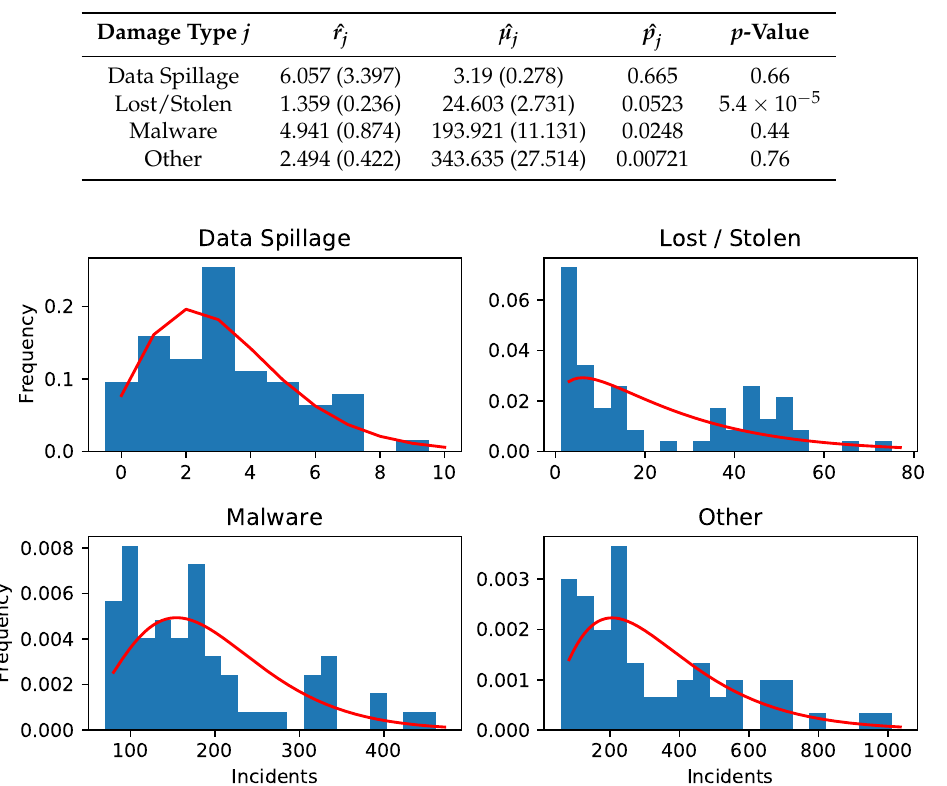
Figure 3. Gaussian KDE estimates of losses three months into the future, constructed from 100,000 simulations with no spending on mitigation. The VaR at the α = 0.01 level is 306,626 dollars; the relevant part of the density is highlighted in red. Table 1. Fit to Counts data. The columns ˆ r j and µ j are returned by the numerical maximum likelihood estimation (with their standard errors) and ˆ p j is found by ˆ p j = ˆ r j / ( ˆ µ j + ˆ r j ) . The results of a chi squared test for goodness of fit of the Negative Binomial distribution to the counts data is also reported.